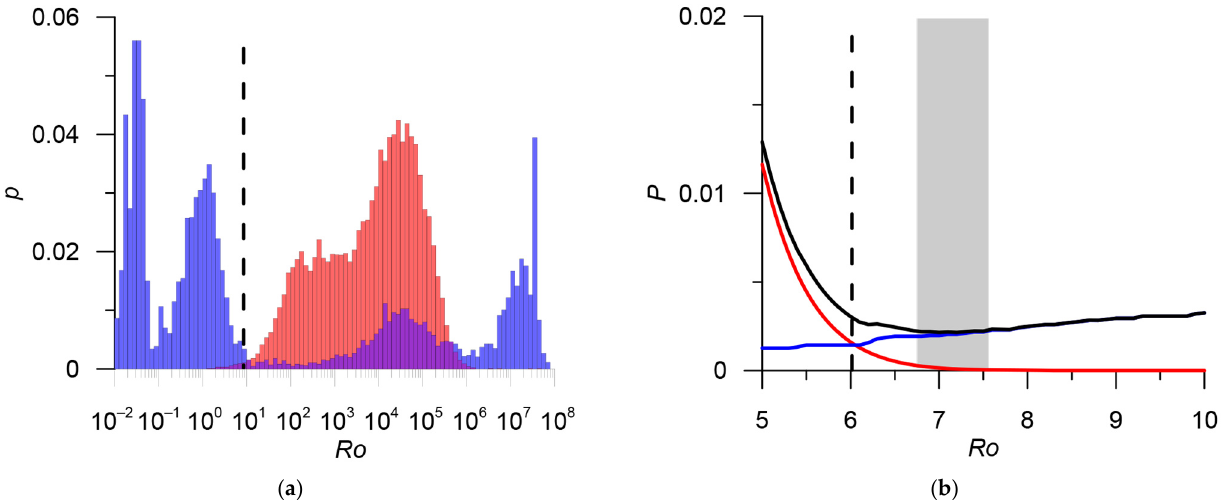
Figure 8. ( a ) Comparison of the metric distribution for RUS/ISC_Other pairs (blue histogram) and the same metric for RUS/RUS earthquakes (red histogram). ( b ) Threshold optimization: the red line is the probability of missing a duplicate in the model with metric (1), the blue line is the probability of a false duplicate, the black line is the total probability of errors of the first and second kind, the dashed line Ro = 6.0 corresponds to an equal number of errors of the first and second kind (number of false duplicates is equal to the number of missed duplicates), the estimate of the total number of errors is approximately 0.3%, and the gray bar shows the range of values for the metric Ro = 6.7 ÷ 7.6, minimizing the total number of errors (approximately 0.2%).